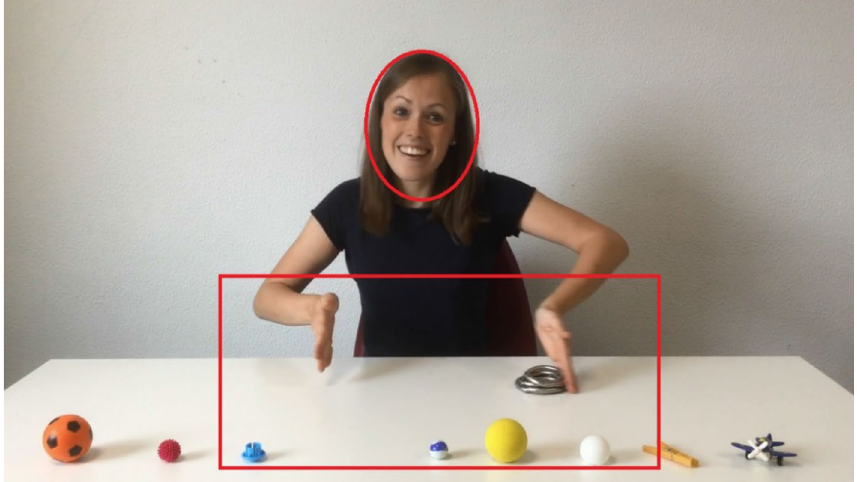
Figure 3. Video-recorded condition. The red oval line represents an interest area for face, the red rectangle line represents an interest area for